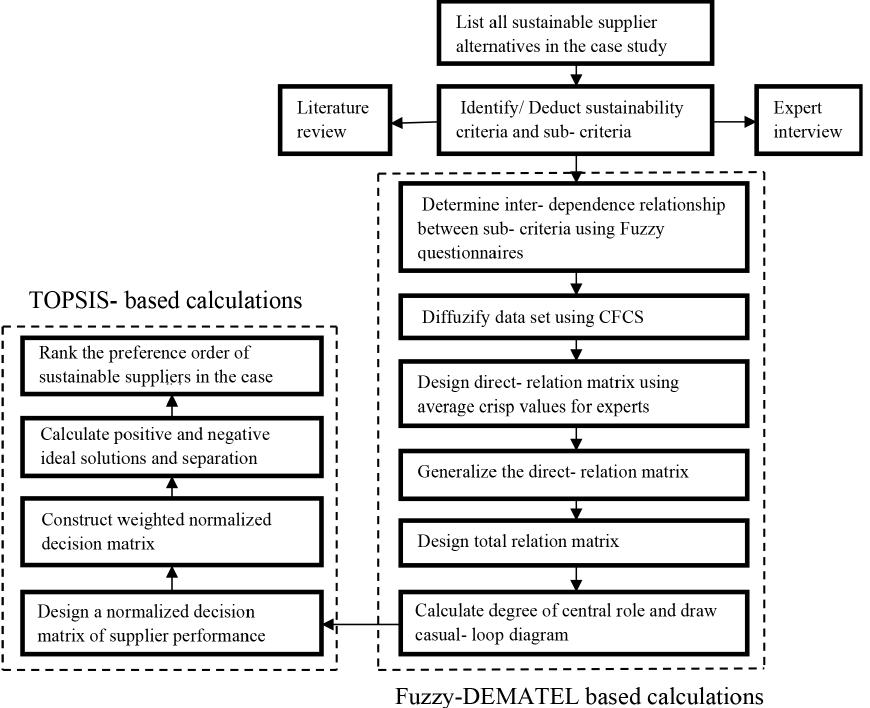
Figure 1. Integrated model for implementing sustainable supplier